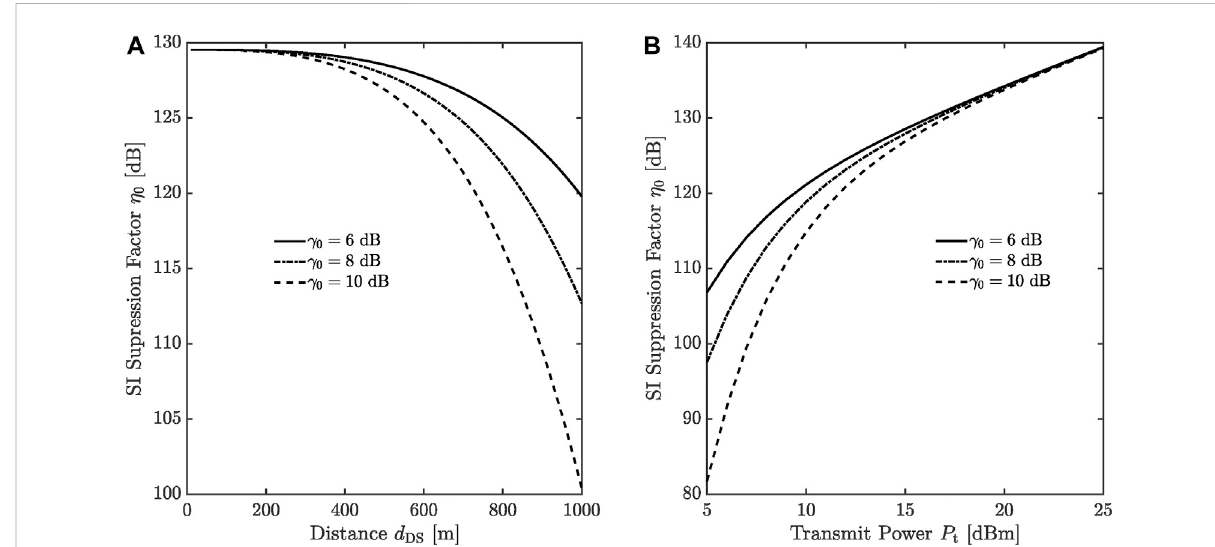
FIGURE 4 The SI suppression factor η 0 : (A) versus the distance d DS , (B) versus the transmit power P t .